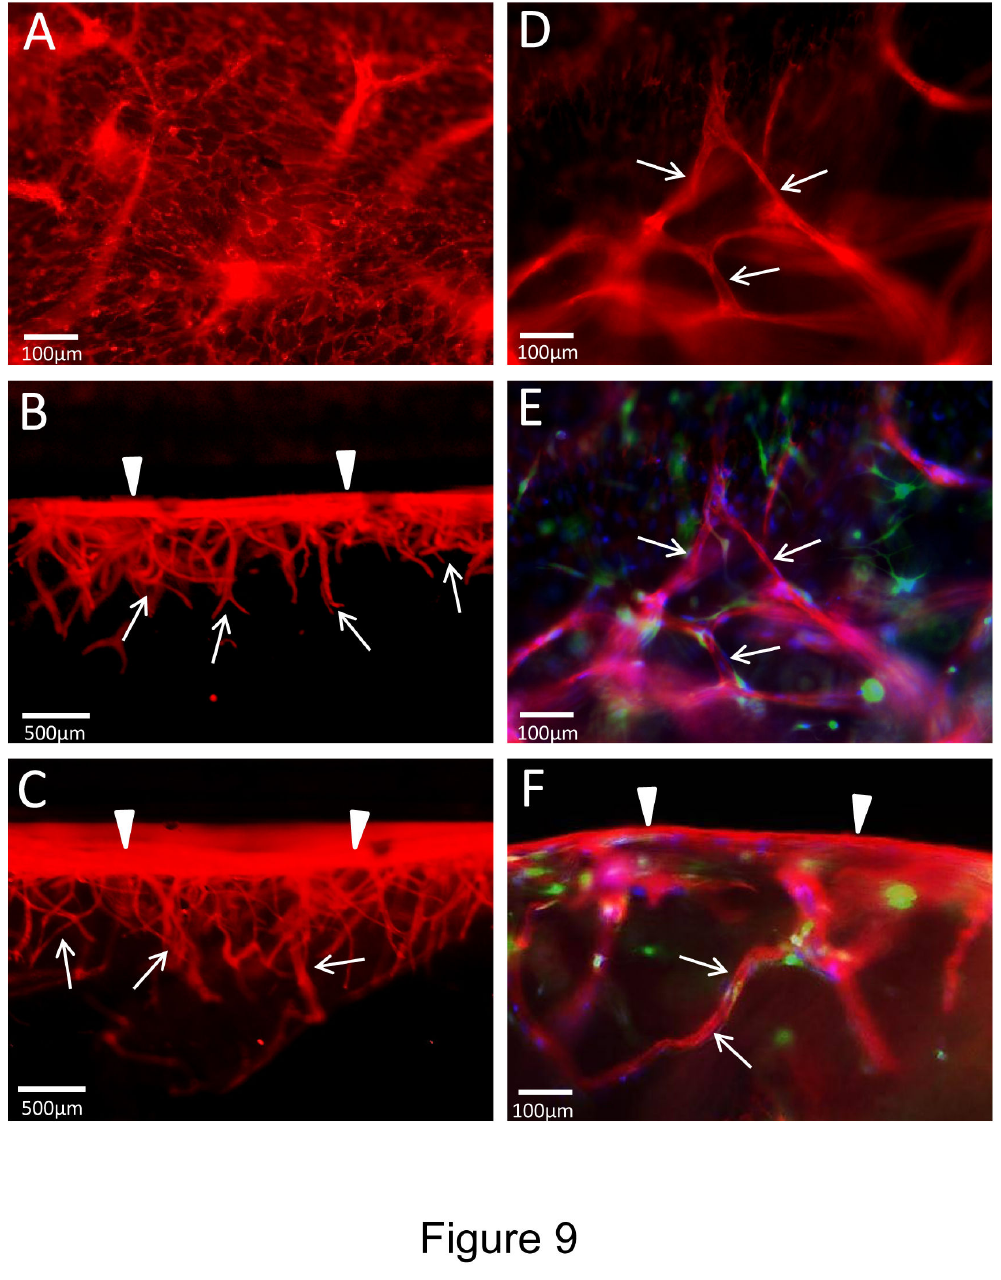
Figure 9. Hematopoietic stem cell cytokines, FGF-2 and pericytes stimulate EC sprouting and tube morphogenesis in 3D fibrin matrices under defined serum-free conditions. GFP-pericytes were seeded into 3D fibrin matrices which contained SCF, IL-3, SDF-1α, Flt-3L and FGF-2. ECs were primed with VEGF/FGF-2 and were seeded on the surface of the polymerized fibrin gels that contained growth factors and pericytes. ECs were allowed to sprout and form tubes for 120 hr prior to fixation and immunofluorescence staining with anti-CD31 antibodies (red). (A) Monolayer surface with visible EC-EC junctions as well as out of focus sprouts invading beneath the EC monolayer. (B,C) Cross sections of the cultures showing the monolayer surface (arrowheads) and invading EC sprouts and tubes (arrows). (D) Invading EC sprouts are observed (arrows) beneath the monolayer surface. (E) Overlay image of (D) showing EC sprouts (red) with associated and surrounding GFP-pericytes (green) and Hoechst dye-stained nuclei (blue). (F) Overlay image showing a cross-section of the EC monolayer (arrowheads) and invading EC sprouts (red) (arrows) with associated and surrounding GFP-pericytes (green) as well as Hoechst dye-stained nuclei (blue). Bar equals 100 µm (A,D,E,F) or 500 µm (B,C). doi: 10.1371/journal.pone.0085147.g009 PLOS ONE |